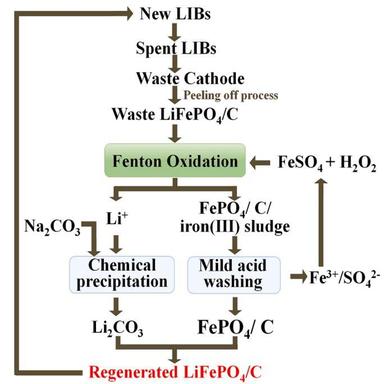
Recycling process for the in-situ extraction of Li and regeneration of LFP from spent LIBs based on advanced oxidation metallurgical technology.